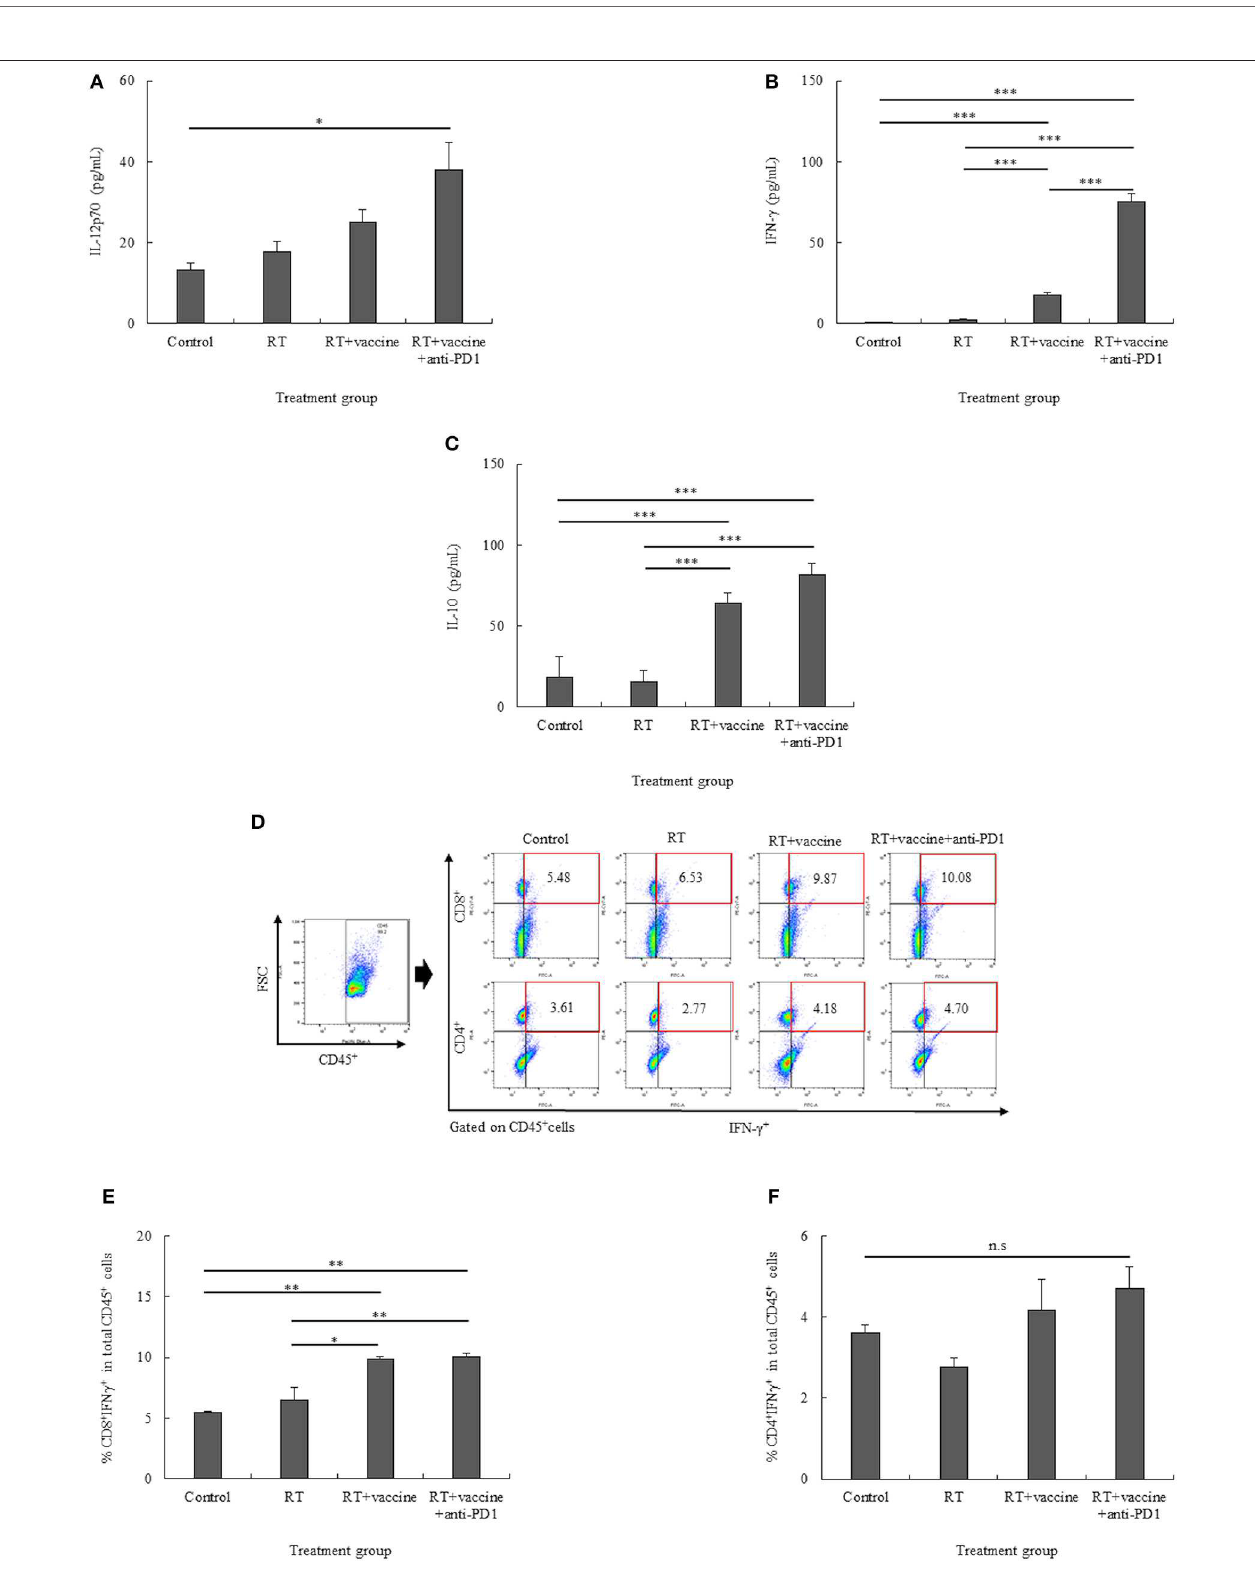
FIGURE 5 | The pro-inflammatory (IL-12p70 and IFN- γ ) and anti-inflammatory (IL-10) cytokine levels in the re-stimulated splenocytes were determined using ELISA (A–C) . The percentages of CD8 + IFN- γ + cells and CD4 + IFN- γ + cells in the re-stimulated splenocytes were also confirmed (D–F) . Data are summarized by bar charts as the mean ± standard deviation (SD). All data are represented as the mean of two independent experiments with total 5 mouse per group. Control, no treatment group; RT, radiation therapy; vaccine, branched multipeptide plus PADRE and poly-ICLC; * p < 0.05; ** p < 0.01; and *** p < 0.001.